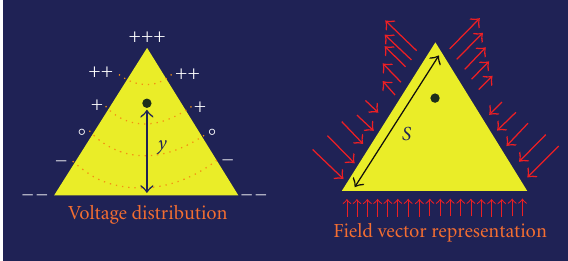
Figure 1: ETMSA voltage distribution and its vector representation.